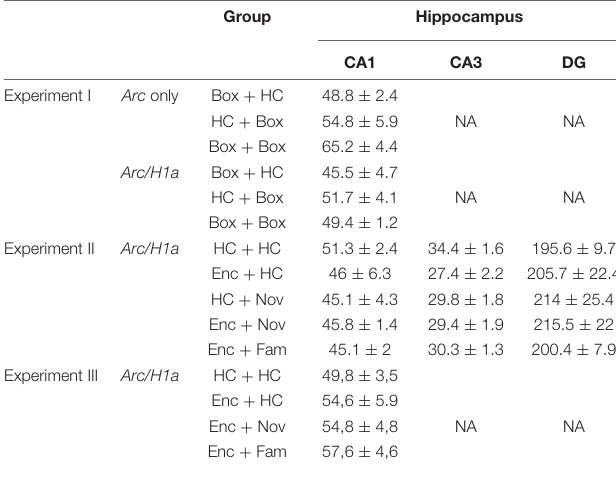
TABLE 1 | Mean of the number of cells per z-stack that was counted in sub-regions of the